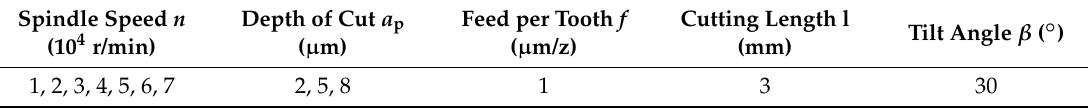
Table 1. The cutting parameters in the experiments.